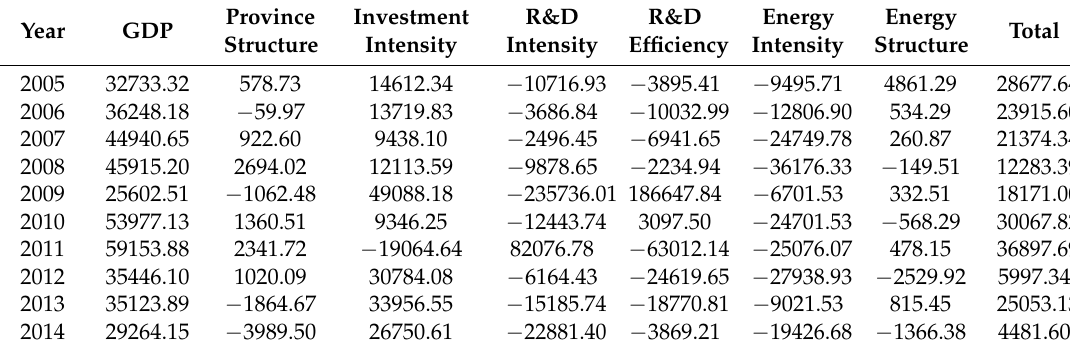
Table 6. The year-by-year effects of different factors of carbon emissions from energy consumption of China in 2005–2014 (unit: 10 4 tons).